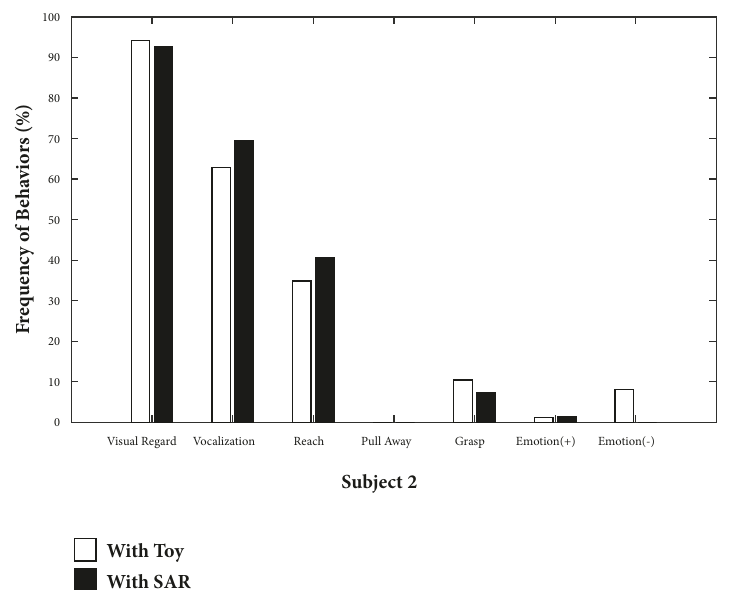
Figure 6: Results for Subject 2, which show a higher level of interaction with the SAR over the switch-adapted toy in both frequency of Vocalization and Reach.